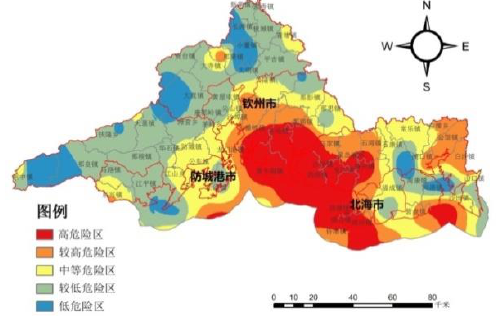
Figure 6. Distribution of tropical cyclone hazards in Guangxi coastal zone